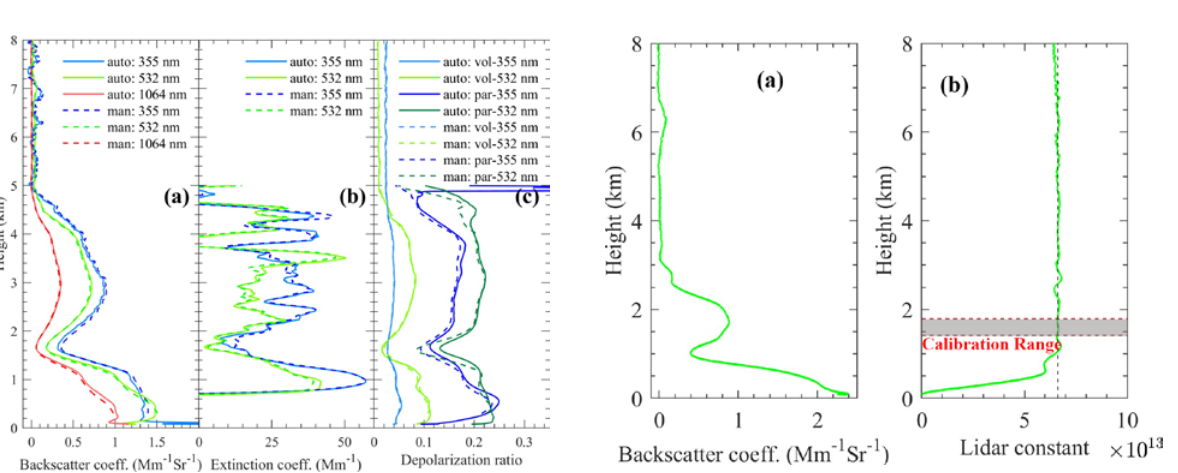
Figure 3. Comparison of manually (man) and automatically (auto) derived aerosol optical properties for 6 April 2017 in Limassol, Cyprus, averaged from 00:00 to 00:59 UTC. (a) aerosol backscatter coefficient at 355 nm, 532 nm and 1064 nm, (b) aerosol extinction coefficient at 355 nm and 532 nm and (c) volume and particle depolarization ratio at 355 nm and 532 nm.